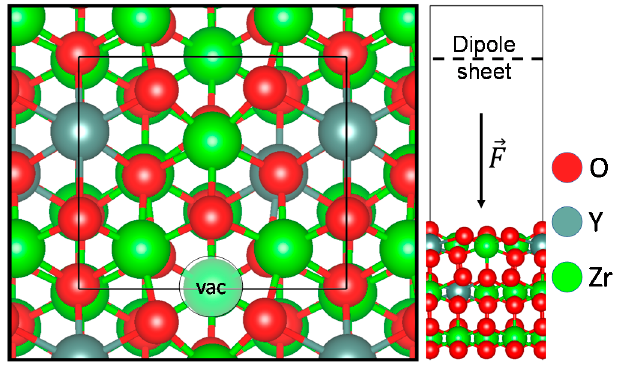
Figure 7. Schematic of the (1 × 1) YSZ (111) model used in the study. The inherent vacancy site annotated on the top view is created upon charge balancing the doping of Y 2 O 3 into ZrO 2 . Annotated by the black arrow on the side view is the direction of a negative